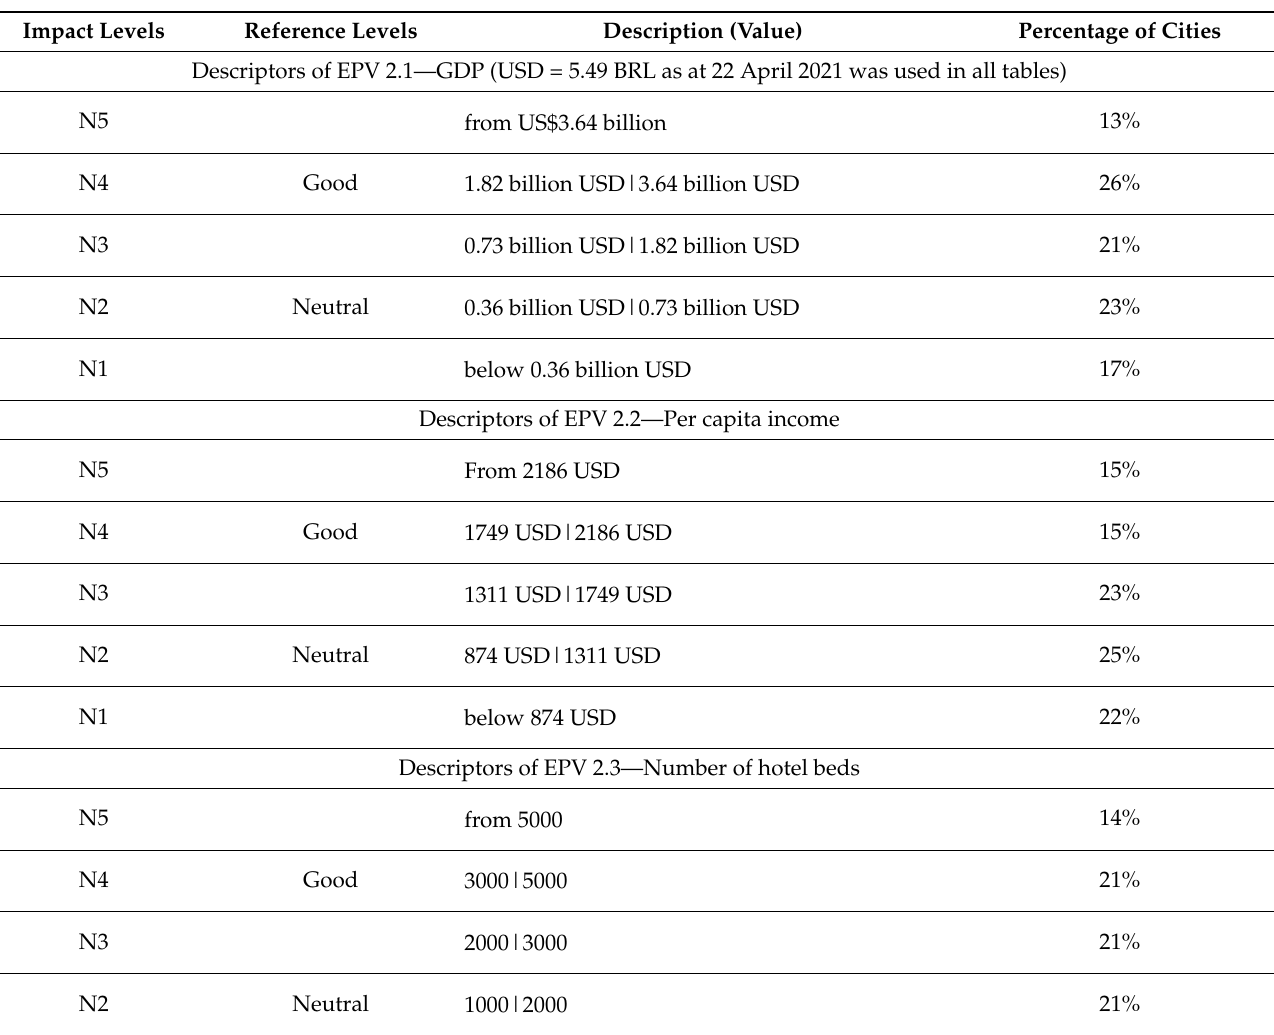
Table 3. Descriptors of FPV 2—economic